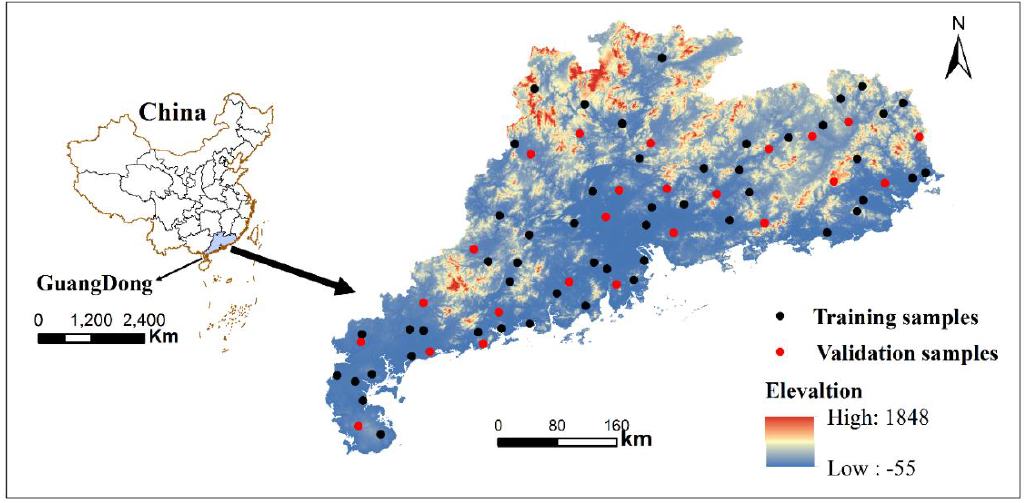
Figure 1. The study area for model development with spatial distribution of soil samples.